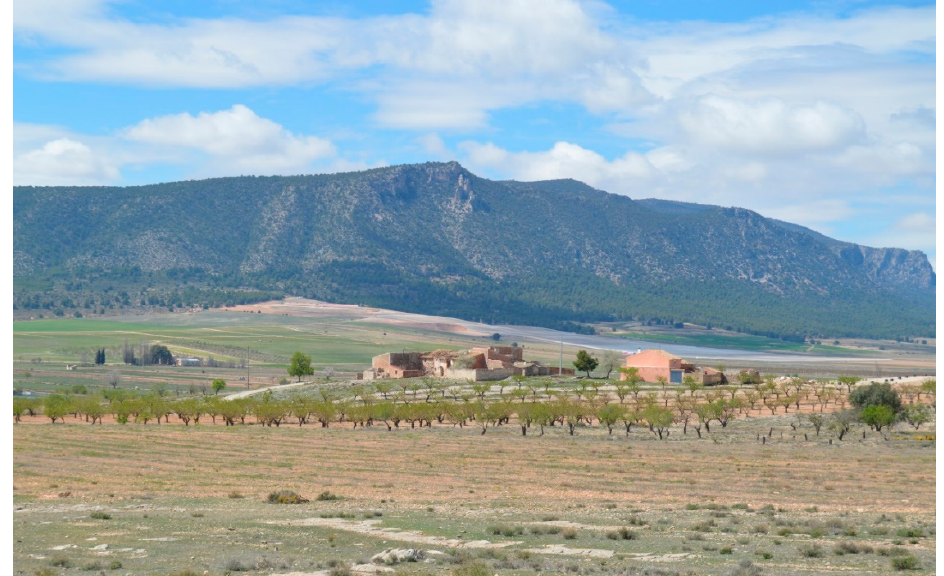
Figure 3. Surface of almond cultivation in rainfed land (Archivel, Caravaca de la Cruz). An old semiabandoned farmhouse can be seen and, in the background, the Sierra de Mojantes (1615 masl). Source: Authors.